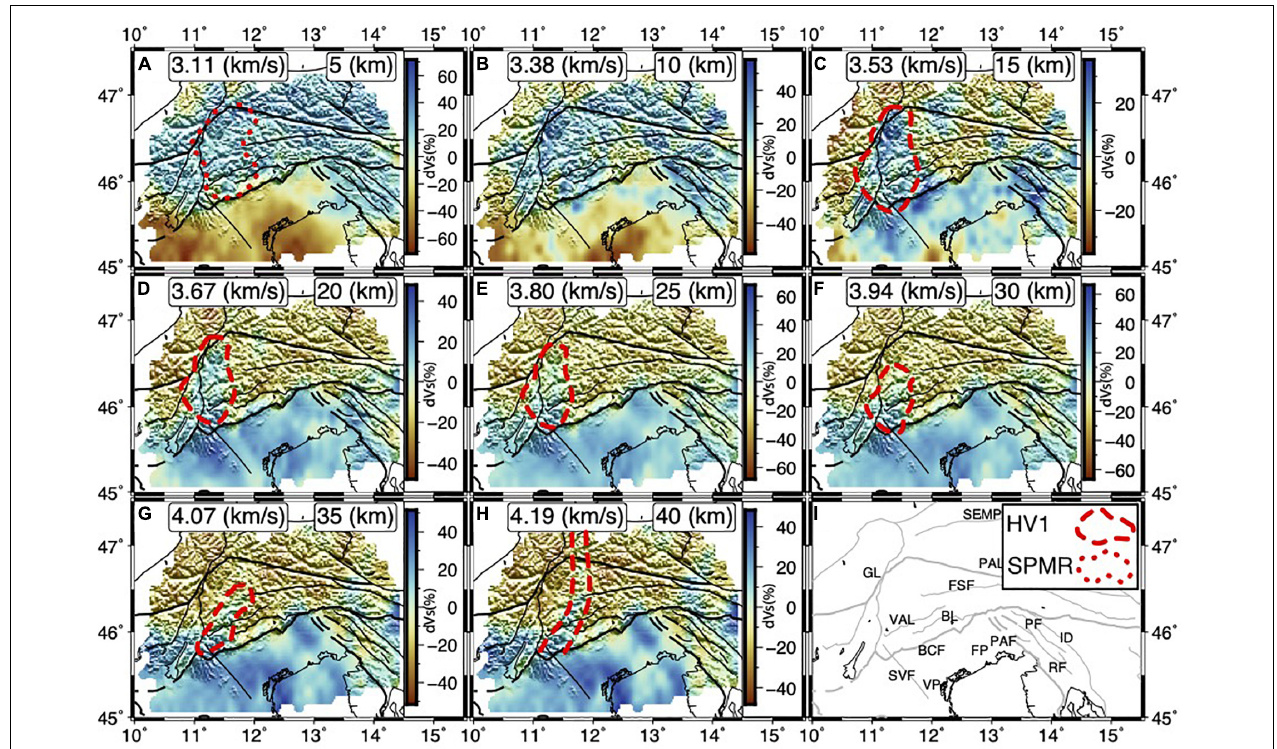
FIGURE 8 | Depth slices showing the S-wave velocity anomalies at 5, 10, 15, 20, 25, 30, 35, and 40 km (A–H) . The average S-wave velocity is shown in each panel. Location of the Permian magmatic rocks observed at the surface is shown in (A) . (I) Map showing the major faults in the region. SPMR, Surface Permian magmatic